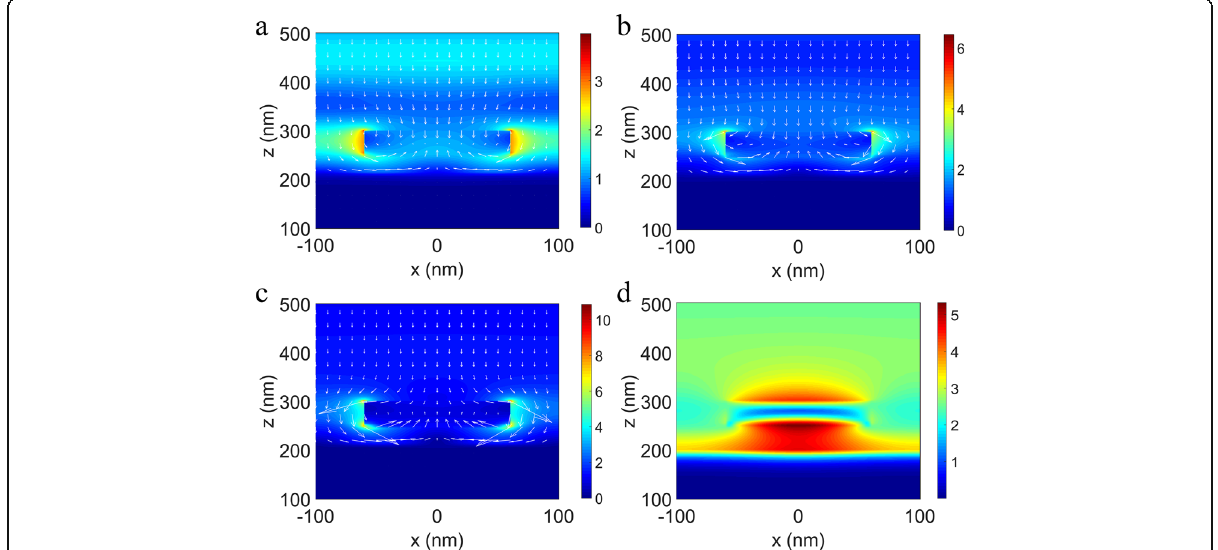
Fig. 6 The distributions of the electric field | E | and the Poynting vectors in the xz plane at y = 0 of a unit cell illuminated with light at